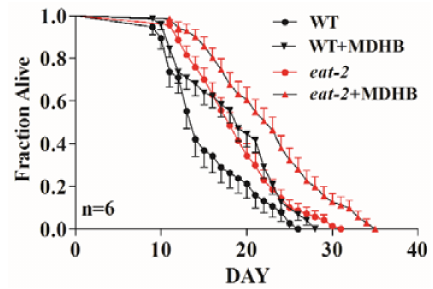
Figure 5. Effects of MDHB on the lifespan of eat-2 (ad1113) mutants. MDHB notably prolonged lifespan of eat-2 (ad1113) mutations from 18.77 ± 0.265 days to 22.60 ± 0.316 days (+20.4%, p = 0.039). Each experiment was repeated at least six times. The data are represented as mean ± S.E.M, the statistical details are generalized in Table